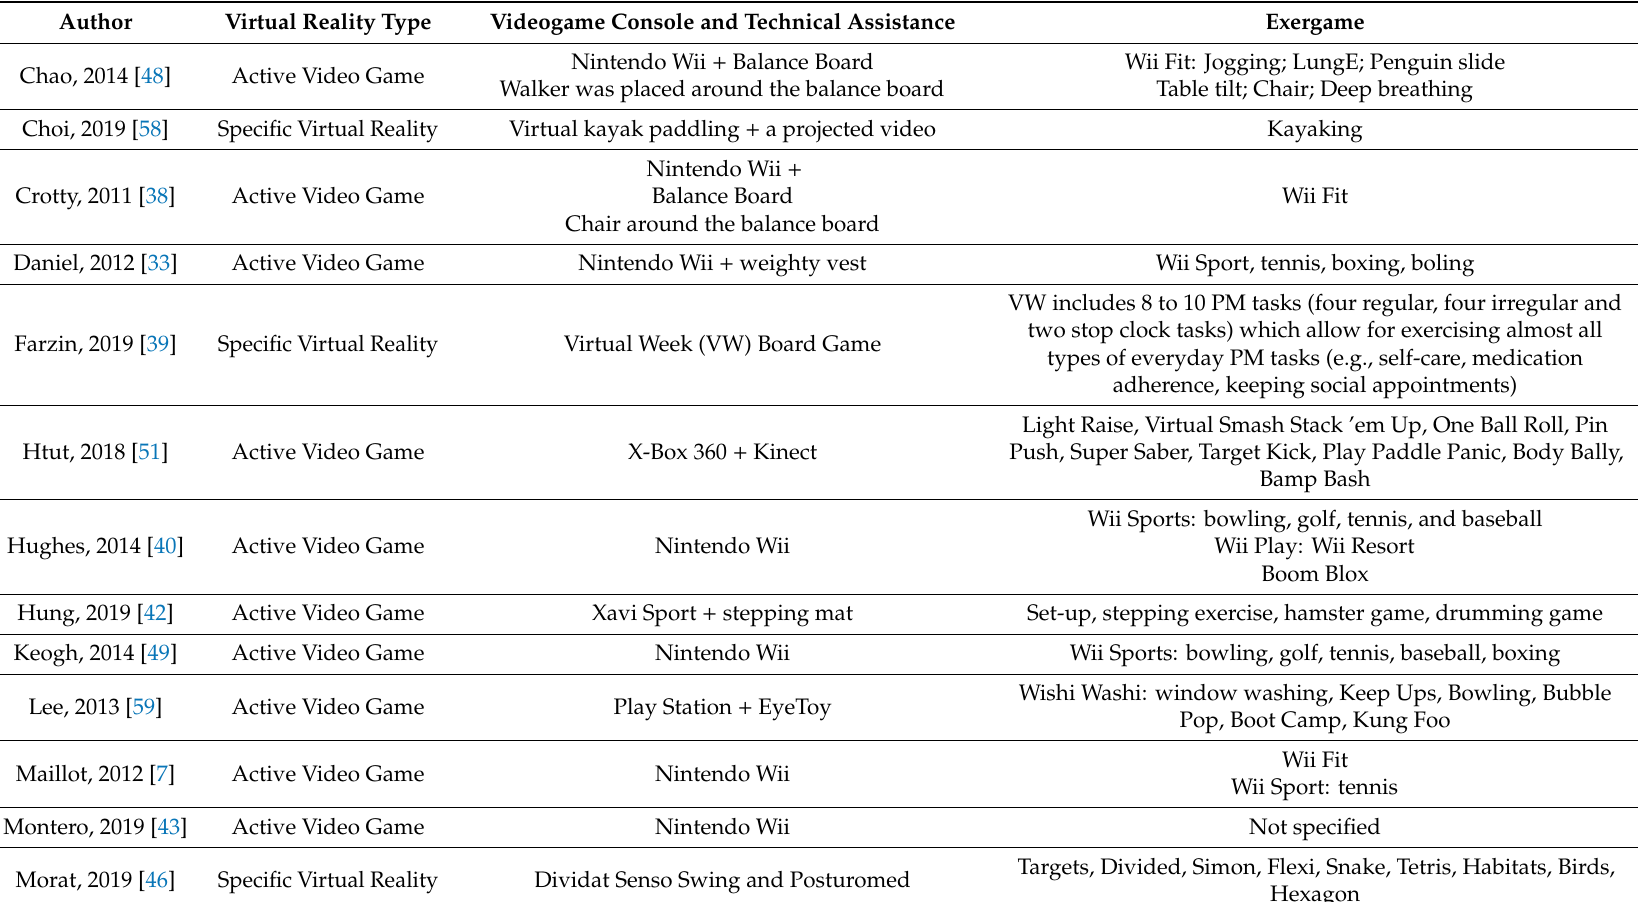
Table A2. Virtual Reality Types, Video Game Consoles and Exergames of Included